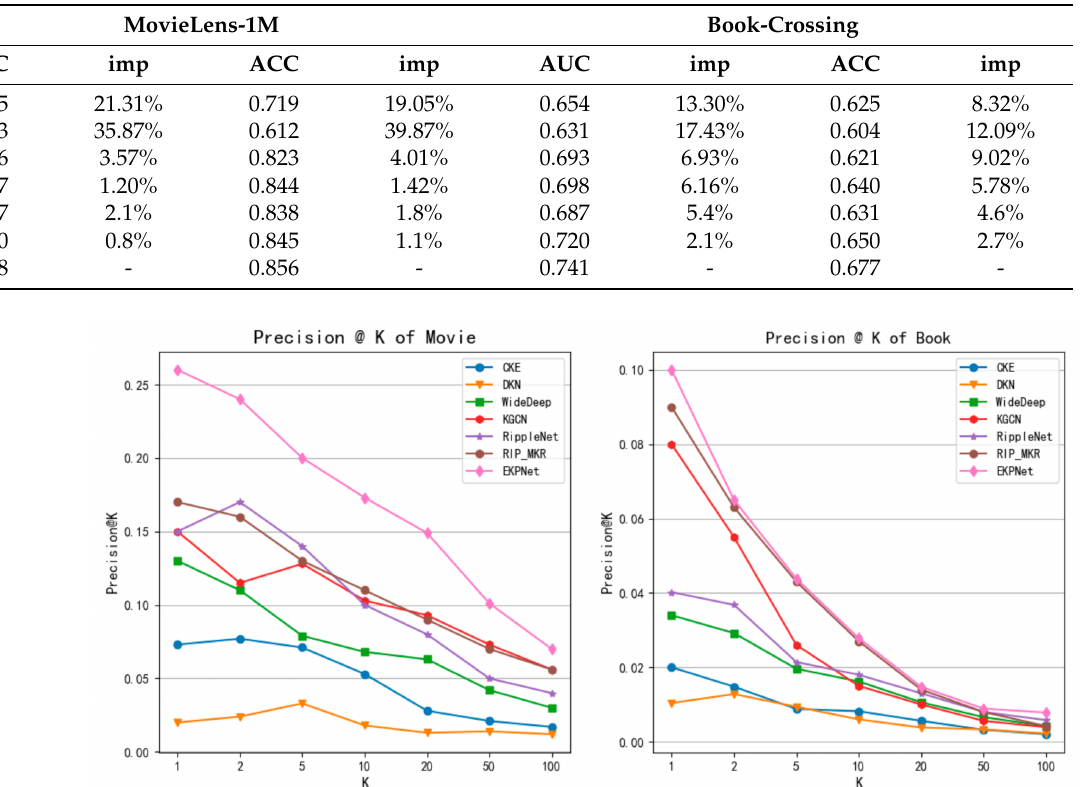
Figure 4. Precision@K of different baselines in the two datasets in the topK task.